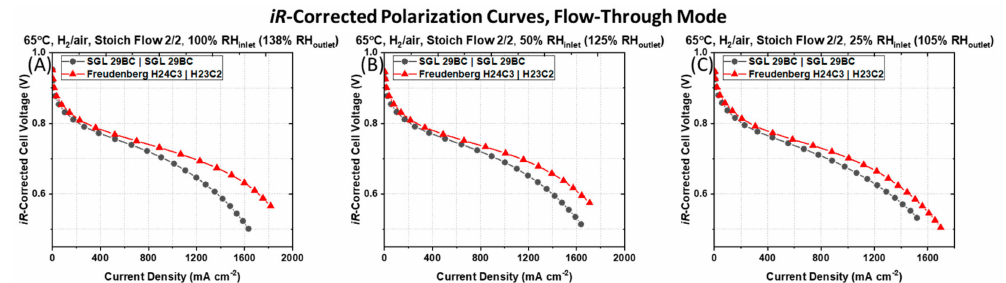
Figure 3. iR -corrected I–V polarization curves measured for a PEMFC containing a typical symmetric pairing of SGL 29BC GDM on the anode and cathode side and a PEMFC containing an asymmetric pairing of Freudenberg GDM (i.e., H24C3 (anode) | H23C2 (cathode)) recorded at a cell temperature of 65 ◦ C, ambient pressure, in H 2 | air environment at stoichiometric flow rates of 2 | 2 at ( A ) 100% RH inlet , ( B ) 50% RH inlet , and ( C ) 25% RH inlet ,